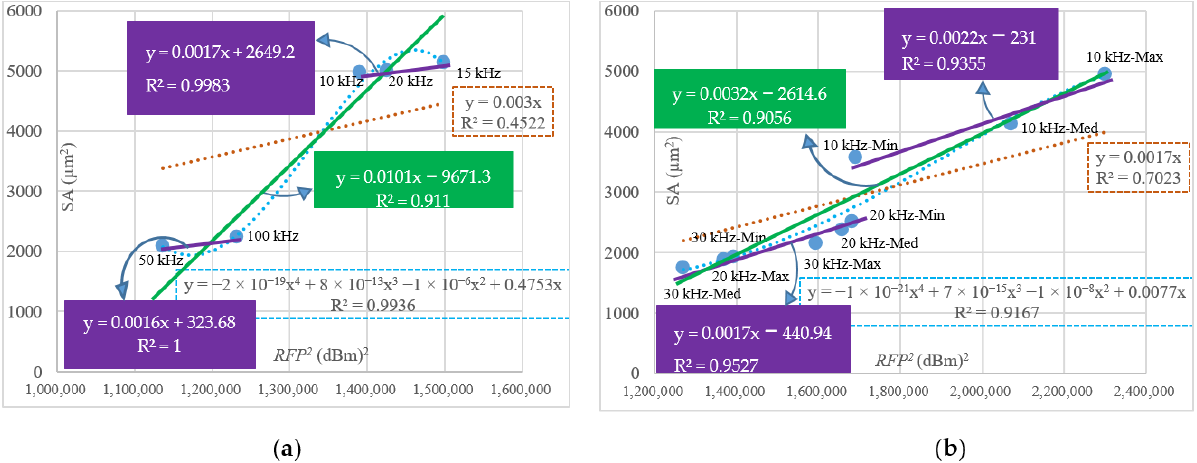
Figure 10. Spatter area (SA) and received RFP 2 corresponding to the two second ablation process for experiments ( a ) Part 1 and ( b ) Part 2. The R-squared value of a fitted polynomial regression is shown using blue, dotted lines (the quartic polynomial for this fit is also shown). The linear regression fit is shown using the brown, dotted lines. The approximate fitted equations for the piecewise linear regression approximations (two purple lines and one green line for each chart) are shown in the coloured rectangles.